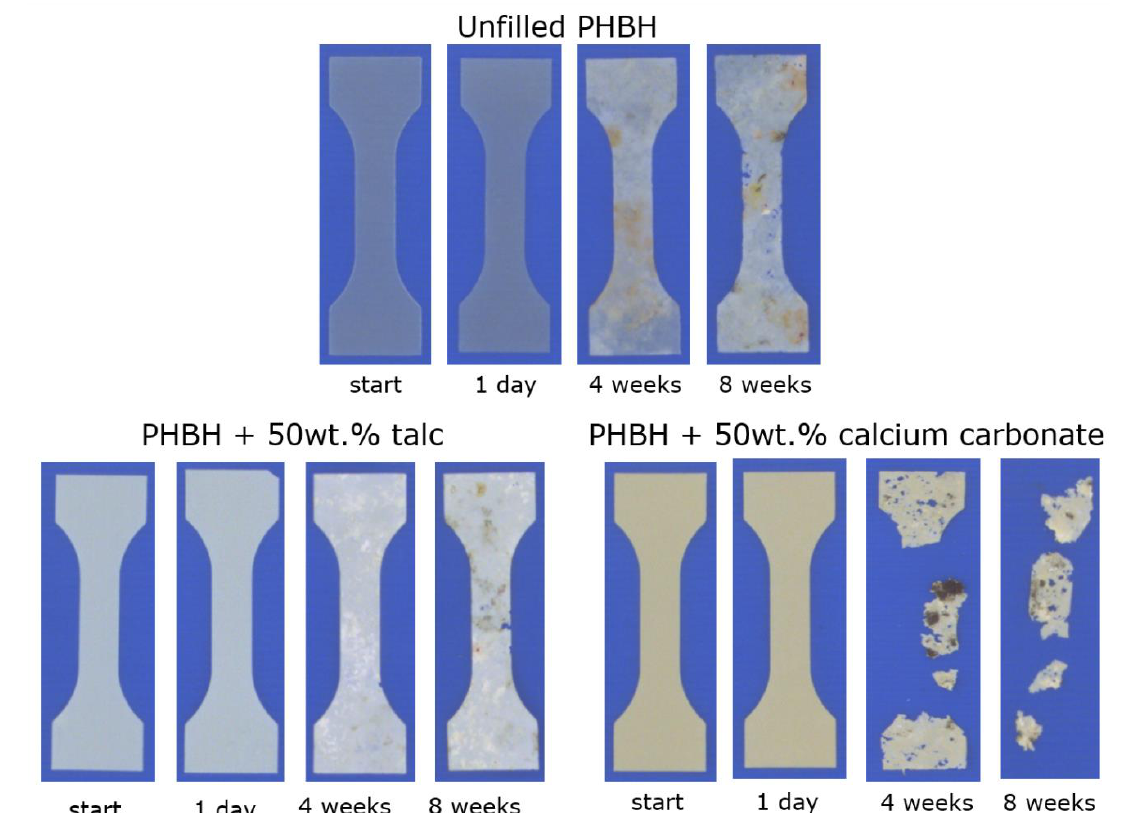
Figure 7. Visual evaluation of biodegradation in soil of unfilled (sheet thickness = 500 μm) and talc- and calcium carbonate- filled PHBH (sheet thickness = 200 μm).